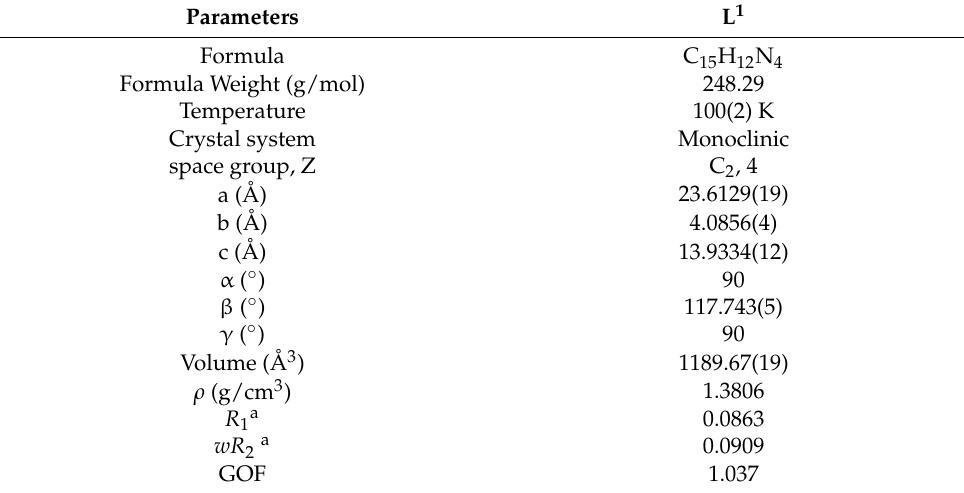
Table 1. Crystal data and details of refinement for L 1